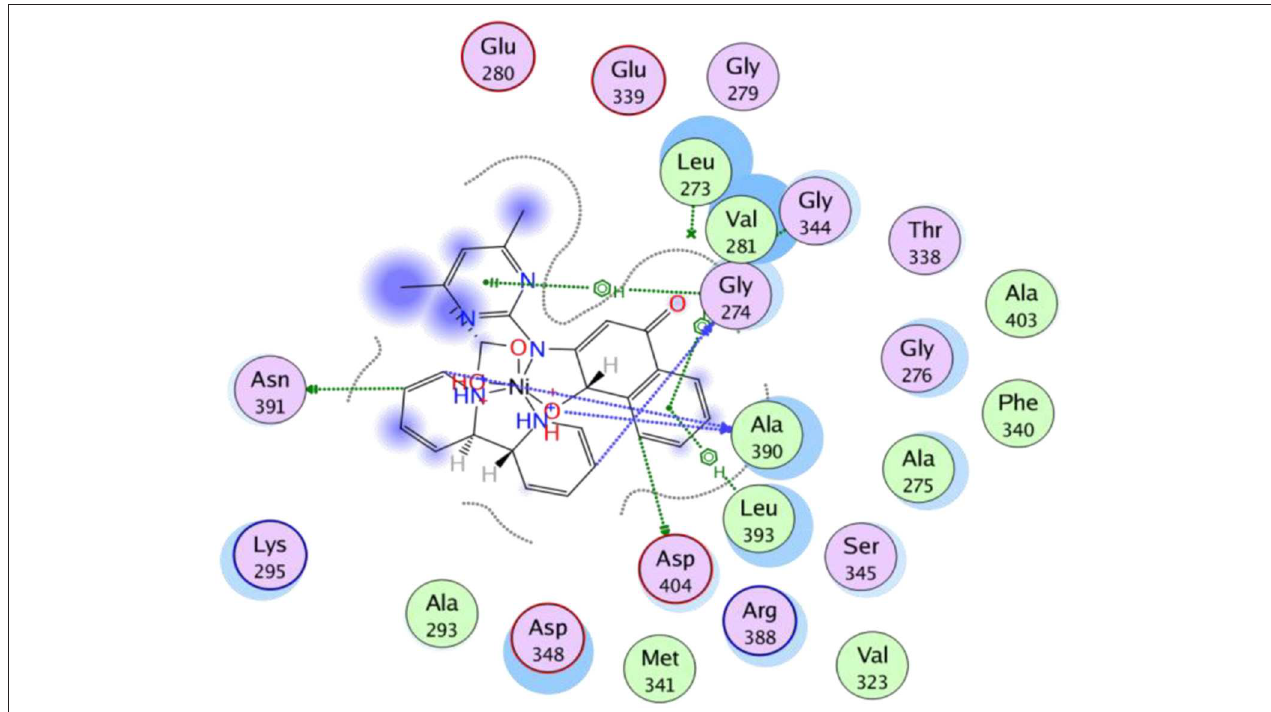
FIGURE 4 | 2D representation of the binding interactions of compound 4 with amino acid residues of 2HCK.